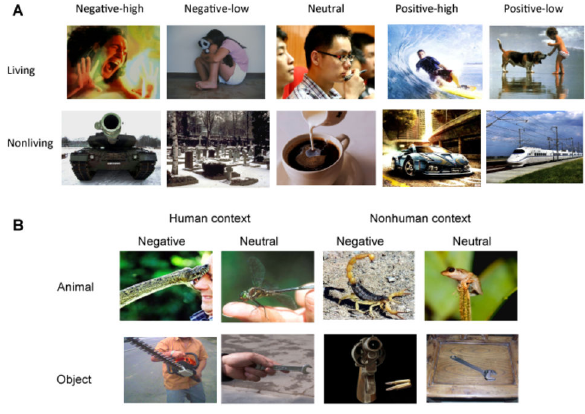
Figure 1. Stimulus example of Experiments 1 and 2.